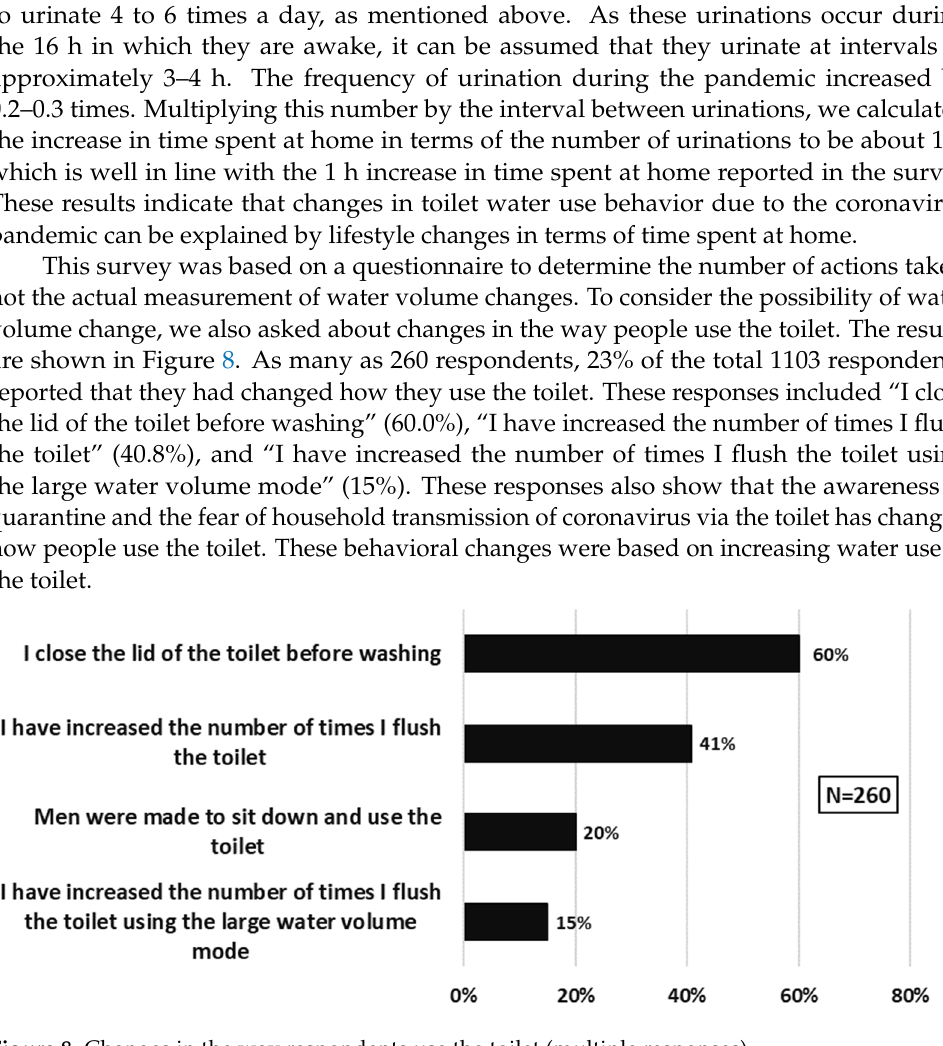
Figure 8. Changes in the way respondents use the toilet (multiple